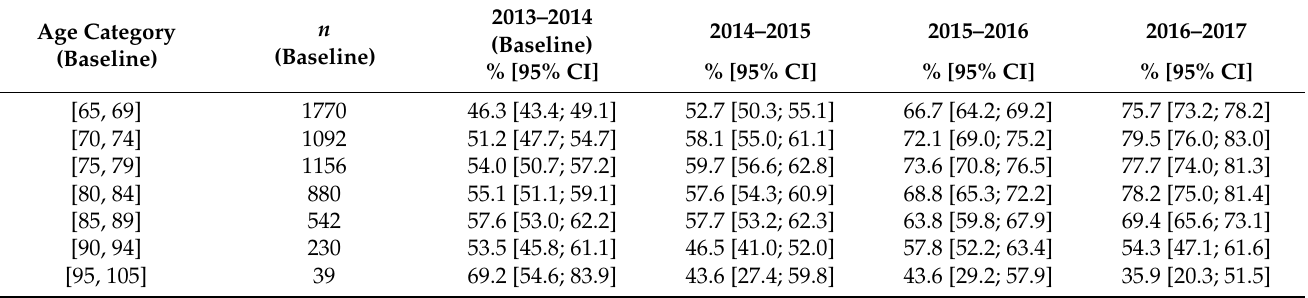
Table 6. Influenza vaccination uptake by age at baseline ≥ 65 group (without chronic